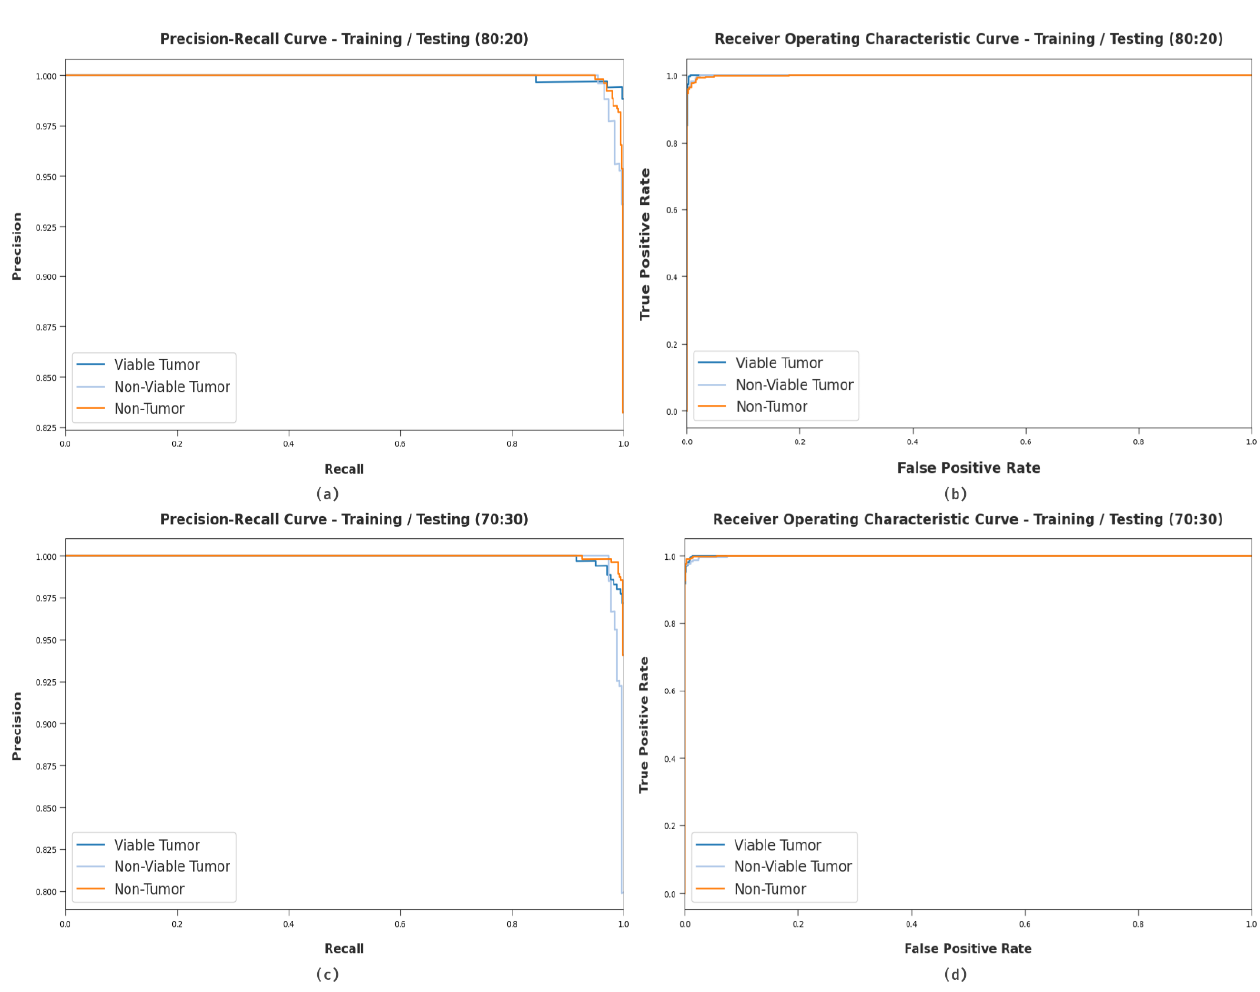
Figure 8. Classification analysis of WDODTL-ODC technique ( a ) 80:20 of precision-recall, ( b ) 80:20 of ROC, ( c ) 70:30 of precision-recall, and ( d ) 70:30 of ROC. Table 3. Comparative analysis of WDODTL-ODC technique with existing